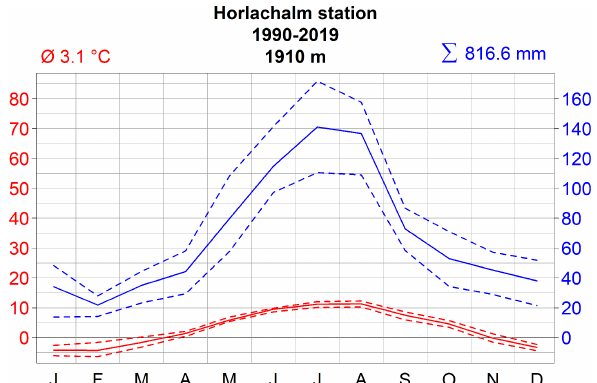
Figure 2. Climate diagram of the Horlachalm station (1910m) us- ing temperature and precipitation data between 1990 and 2019. Upper dashed lines represent 75% percentiles; lower dashed lines show the 25% percentiles. Data source: